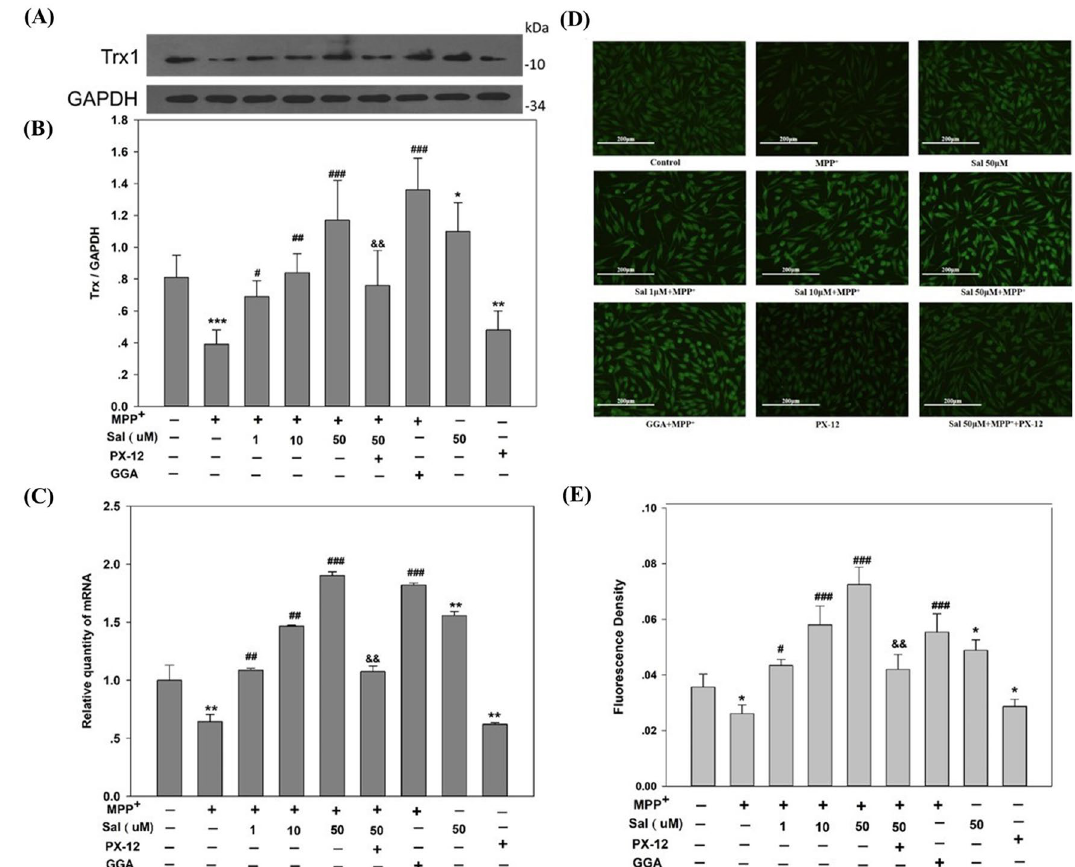
Figure 4. Schisanhenol increases Trx1 protein and mRNA expression in SH-SY5Y cells treated with MPP + . SH-SY5Y cells were treated with Sal (1 µM, 10 µM, and 50 µM) for 24 h before exposed to MPP + (500 μΜ) for 48 h. ( A ) Trx1 protein levels were assayed by Western blot. A representative blot of six separate experiments was shown; ( B ) Quantification of band intensities of ( A ), Trx1 was normalized to GAPDH using Gel-Pro Analyzer 4.0 software, and the ratio of Trx1 to GAPDH was calculated; ( C ) Trx1 mRNA levels was analyzed with qPCR. Data were obtained from six separate experiments and each was repeated three times; ( D ) Trx1 expression was detected by immunofluorescence staining. The images represent the results from six independent experiments; ( E ) Quantification of Trx1 protein expression of ( D ) was performed using Image-Pro Plus 6.0. Data were expressed as mean ± SD. * P < 0.05, ** P < 0.01, *** P < 0.001 vs Control group; # P < 0.05, ## P < 0.01, ### P < 0.001 vs MPP + group; && P < 0.01 vs Sal 50 μM + MPP + group. Each experiment was conducted in